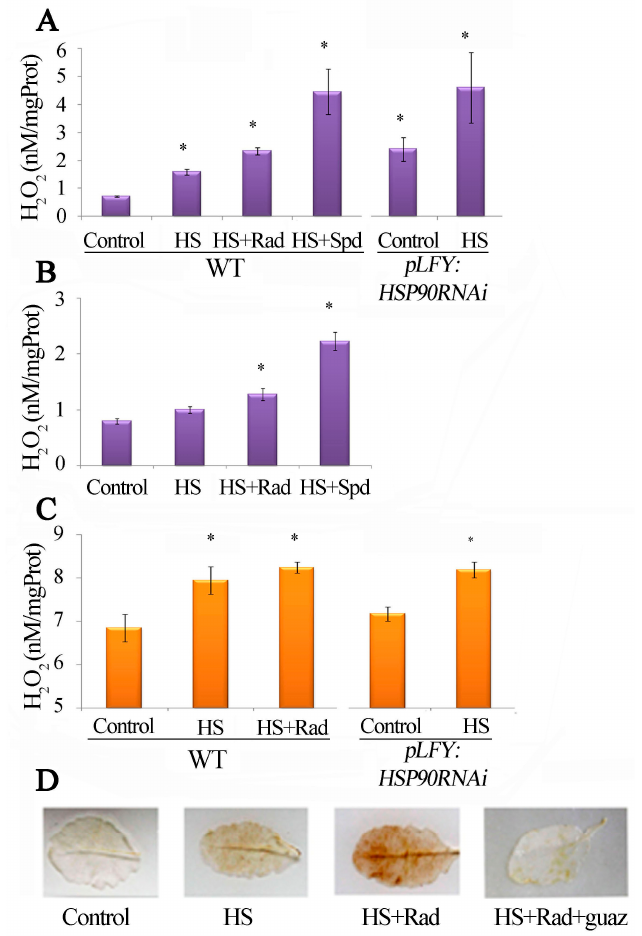
Figure 5. Inhibition of HSP90 stimulates the polyamine oxidation activity. Polyamine Oxidase (PAO) activity measured and evaluated through hydrogen peroxide production in: (A) Excised WT leaves cultured on MES medium and exposed to HS with/without Rad; and excised pLFY:HSP90RNAi line leaves cultured on MES medium and exposed to HS. (B) In planta WT leaves infiltrated separately with water (control or HS); Rad, and Spd (as positive control) prior to exposure to HS. (C) Luminometric hydrogen peroxide quantification in WT leaves exposed to HS and HS + Rad, and pLFY:HSP90RNAi mutant exposed to HS. ( D ) In situ DAB staining of hydrogen peroxide in WT control leaves treated with HS and HS + Rad and with HS + Rad + guazatine (Guaz). Values from 8 replicates from two independent experiments were pooled for statistical analysis. Asterisks indicate statistically significant differences from WT control ( p < 0.05).